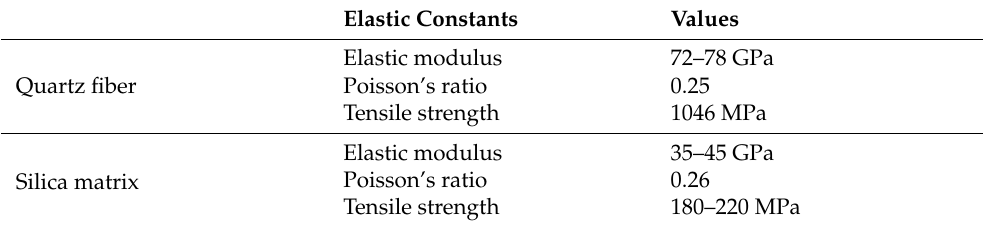
Table 3. Material properties of pristine quartz fiber and silica